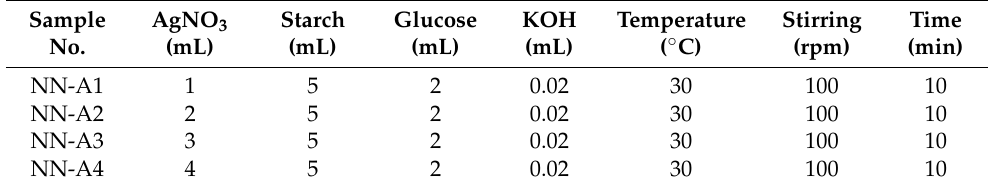
Table 1. Experimental details for different volume ratios of AgNO 3 , starch, and glucose during the synthesis of